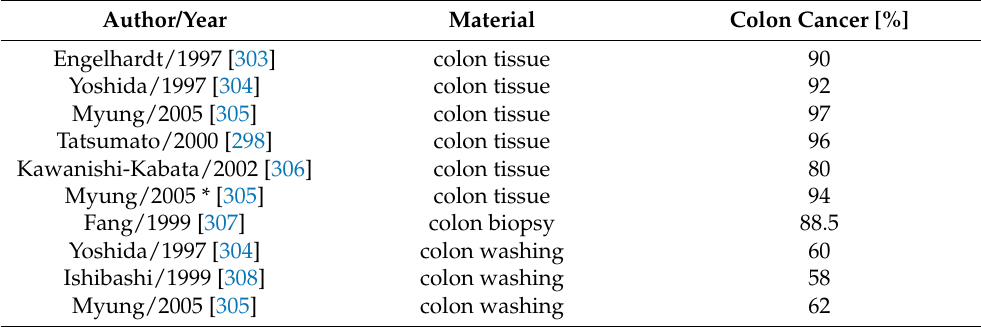
Table 6. According to Chen and Chen in modification: telomerase activity in colon cancer